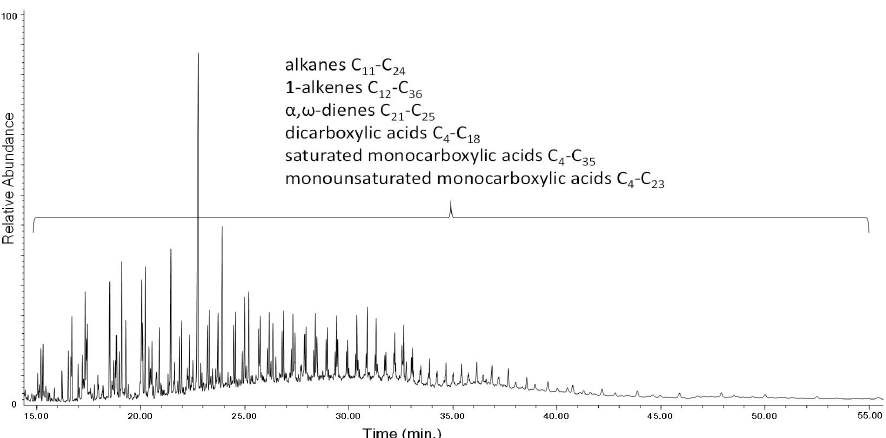
Figure 14. Chromatogram obtained in the Py(HMDS)–GC–MS analysis of the DCM extract of LDPE- 4w. The list of the main pyrolysis products is reported in Table S10 in Supplementary